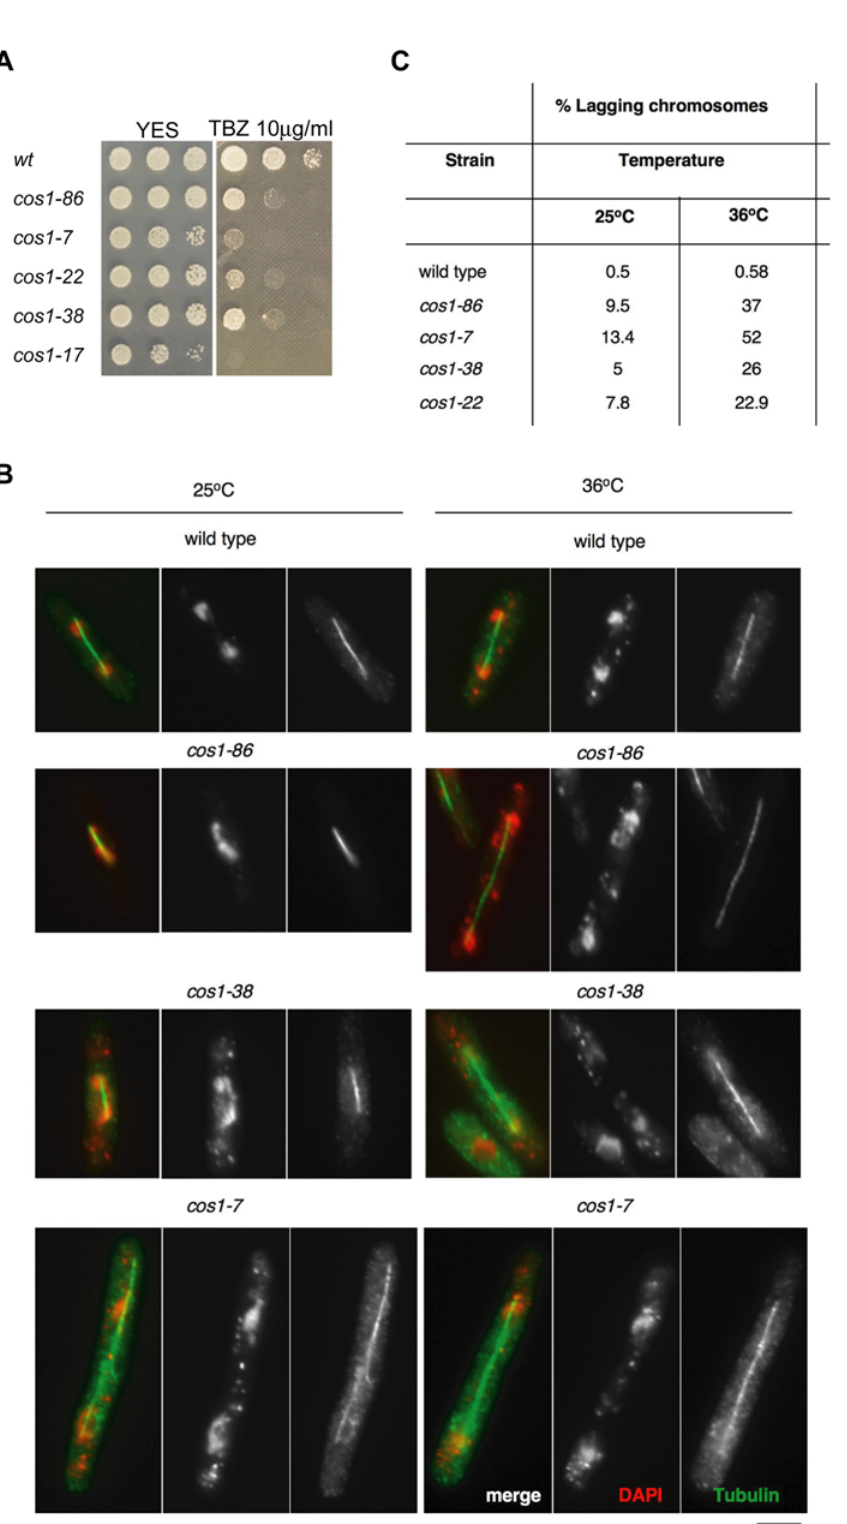
Figure 2. Chromosome segregation defects in cos1/mcl1 mutants. ( A ) cos1 mutants are sensitive to the microtubule destabilizing drug TBZ. Tenfold serial dilutions were spotted onto YES media containing 10 m g/ml TBZ. ( B ) Wild-type and cos1/mcl1 mutant cells were grown at 25 u C or at 36 u C for 6 hours before fixing and staining with anti- a -tubulin antibody (green) and DAPI stained DNA (red). Bar, 3 m m. ( C ) Frequency of lagging chromosomes in cos1/mcl1 mutants. Lagging chromosomes were counted in cells with late anaphase spindles and are given as a percentage of total number of cells in anaphase (n=200). Lagging chromosomes were very rare in wild-type (0.5–0.58%) at both temperatures.